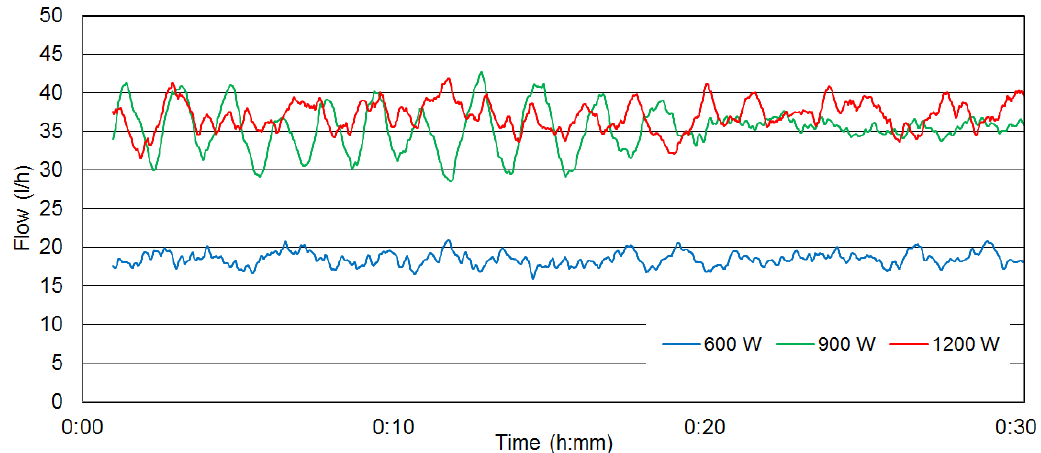
Figure 12. Flow rate of the liquid heat transfer medium represented by moving average trend lines (time period - 60) at 600, 900 and 1200 W.